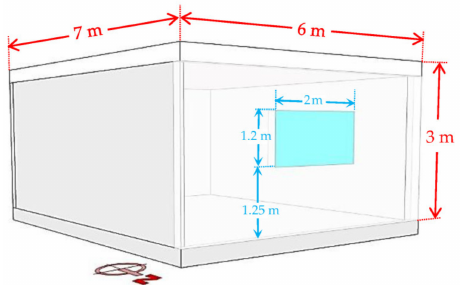
Figure 2. The case room and window